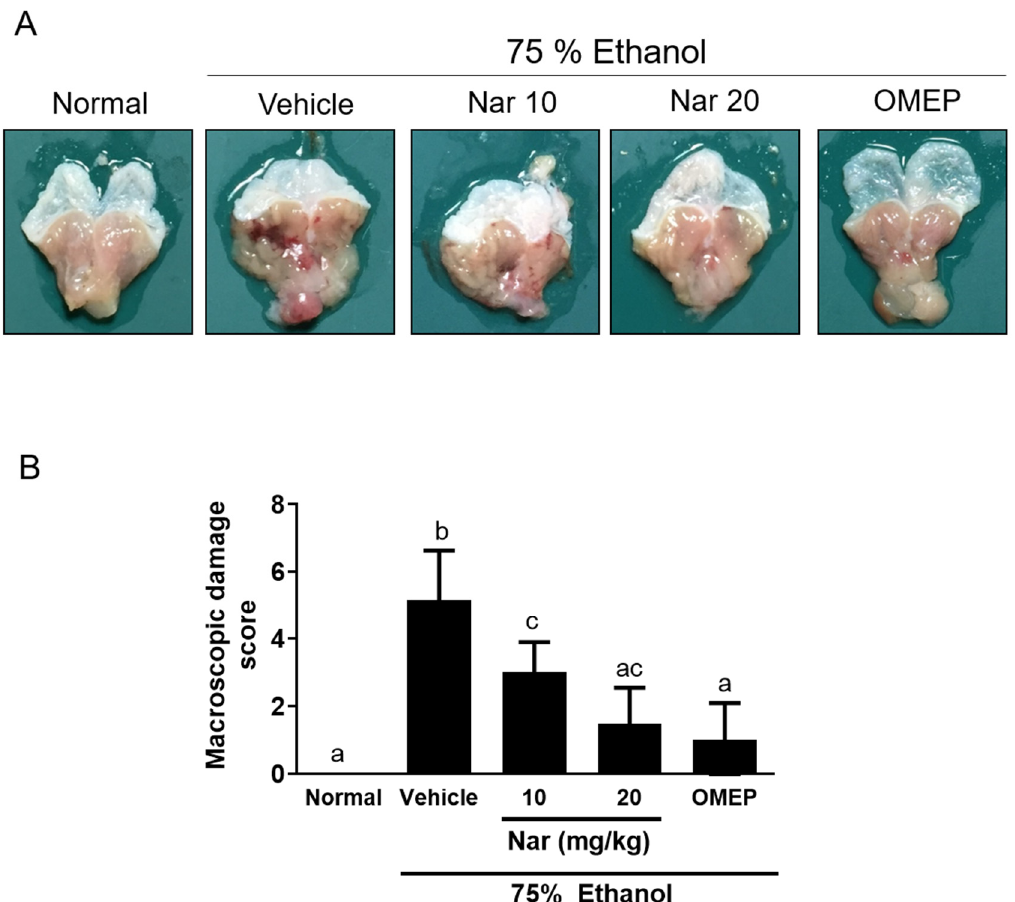
Figure 1. Naringenin improved the macroscopic morphology of gastric damage induced by ethanol in mice. C57BL/6 mice were randomly assigned to 5 different groups (6 mice per group). The vehicle (10% dimethyl sulfoxide (DMSO) and 90% glyceryl trioctanoate), naringenin (Nar, 10 and 20 mg/kg) and omeprazole (OMEP, 20 mg/kg; used as a positive control) were given orally for a period of 3 days. After fasting for 12 h prior to the experiment, mice were fed orally with ethanol (0.5 mL/100 g body weight) to induce the acute ulcer. After 4 h, mice were sacrificed. In the normal control group, the mice only received vehicle (Normal). ( A ) Representative photos of the dissected stomach. ( B ) The scores for macroscopic gastric damage. The data obtained from individual animal samples per group were averaged ( n = 6); values represent mean ± standard deviation (SD). Statistical comparison was analyzed by a one-way ANOVA followed by Tukey’s multiple comparison tests. Bars not sharing a common letter represent a statistically significant difference ( p < 0.05).